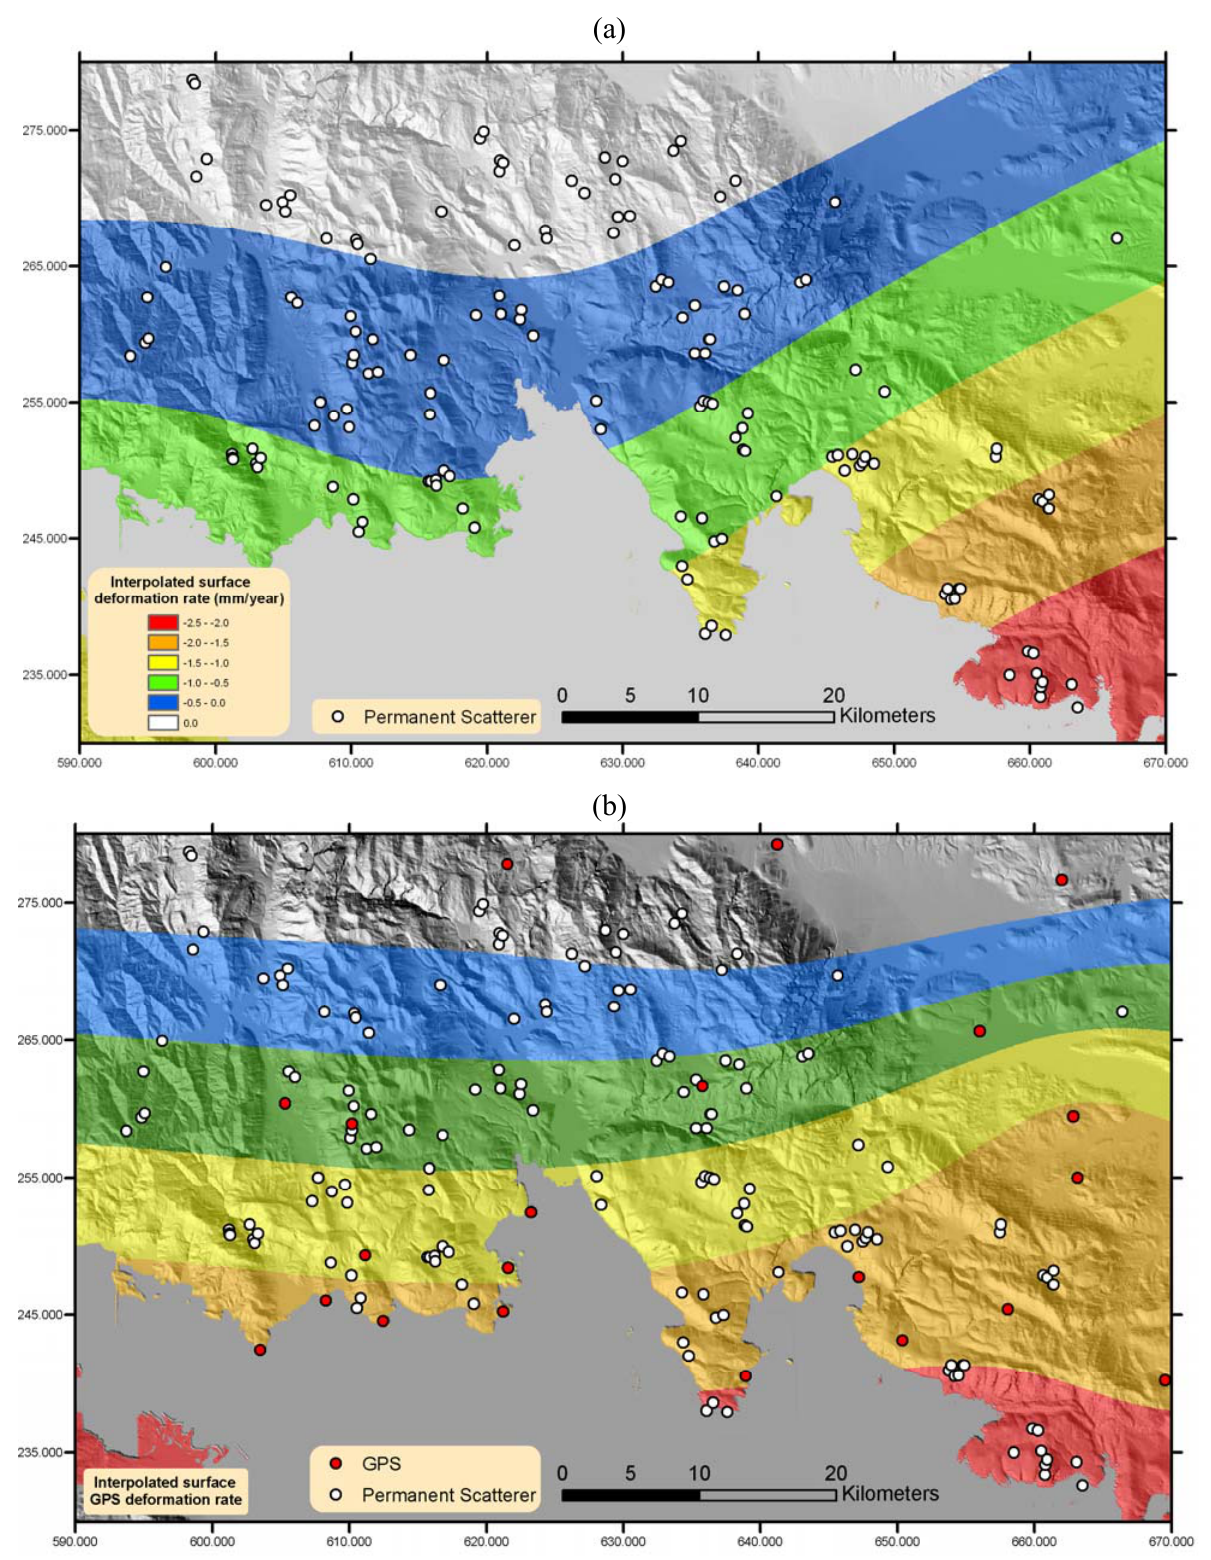
Figure 4. (a) Bilinear PS interpolated surface and the corresponding PSs. (b) Deformation surface derived from GPS measurements. White dots correspond to PS measurement points while red dots to GPS